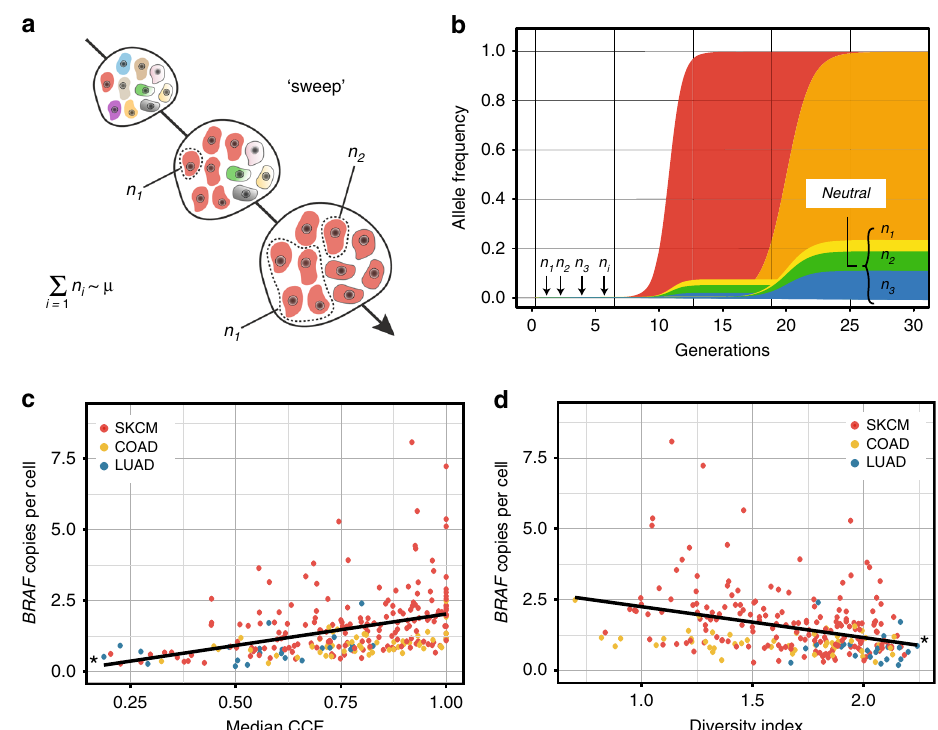
Fig. 4 BRAF -variant multiplicity regulates subclonal dynamics. a Schematic of a selective sweep. The subclone under selection is in red. Progression along the arrow represents evolving clonal architecture. The accumulation of the i th passenger alleles associated with the subclone during selection (or hitch- hikers) is shown. μ is the neutral mutation rate. There is decreased genetic diversity as a result of the yielding of tumor subclones to a single clonal cluster if there is a rapid or hard selective sweep. b Modeling of the frequency trajectory of a new adaptive and i th passenger mutation during a selective sweep. Sweep parameters are s = 2.0 (hard) or 1.1 (soft) and μ = 0.001. The linear associations between the BRAF -variant multiplicity and the median c CCF or d genetic diversity across cancer types are shown. The slopes are non-zero ( P <